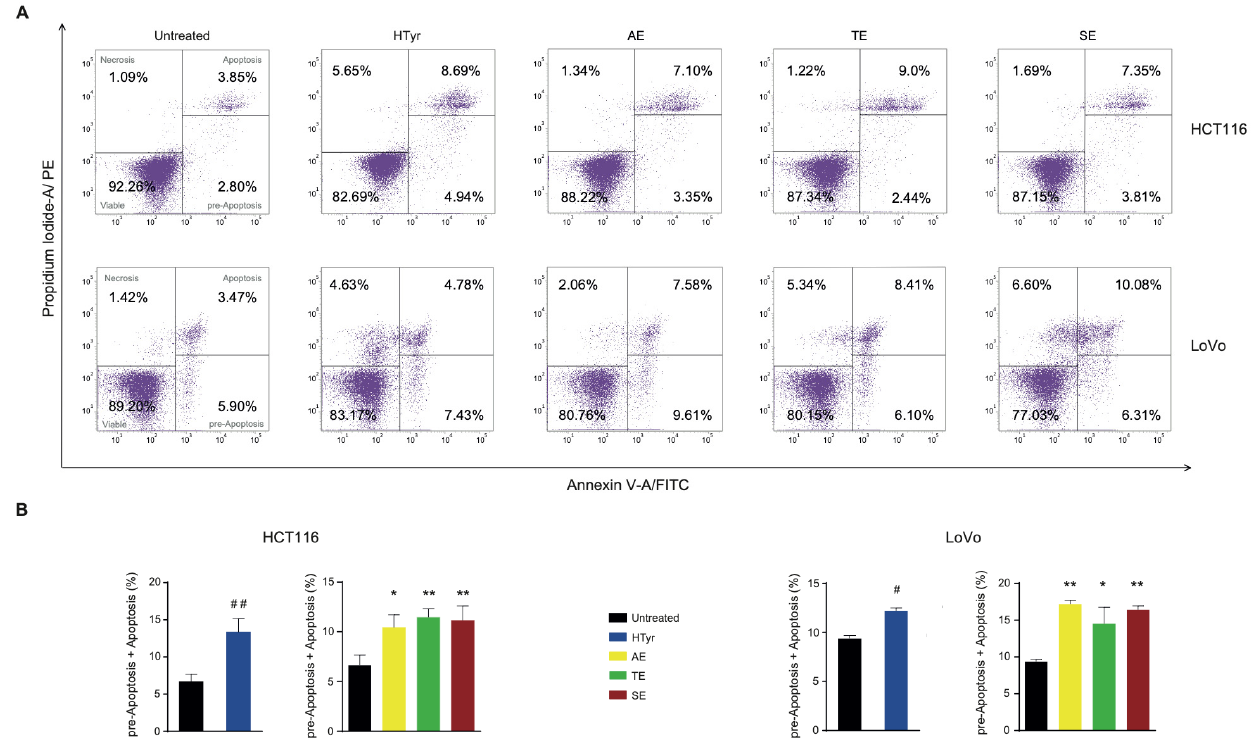
Figure 4. Hydroxytyrosol and OPWPs extracts promote programmed cell death in colorectal cancer cells: ( A ) Flow cytometry analysis of Annexin V/Propidium Iodide of HCT116 stained cells, treated with 0.0154 mg mL − 1 of either HTyr or OPWPs extracts (upper panel) and LoVo cells treated with 0.0231 mg mL − 1 of either HTyr or OPWPs extracts (lower panel) for 72 h. Viable cells are comprised in the lower left quadrant; necrotic cells in the upper left; pre-apoptotic cells in the lower right and apoptotic cells in the upper right. The number reported in each quadrant indicates the relative percentage of cells. ( B ) The histograms report the percentages of cells undergoing apoptosis calculated by adding both the pre-apoptotic and apoptotic cells treated with HTyr or OPWPs extracts with respect to untreated cells. Statistical significance is considered when # p ≤ 0.05, ## p ≤ 0.01 ( t -test) or * p ≤ 0.05, ** p ≤ 0.01 (ANOVA with Dunnett’s post-test).